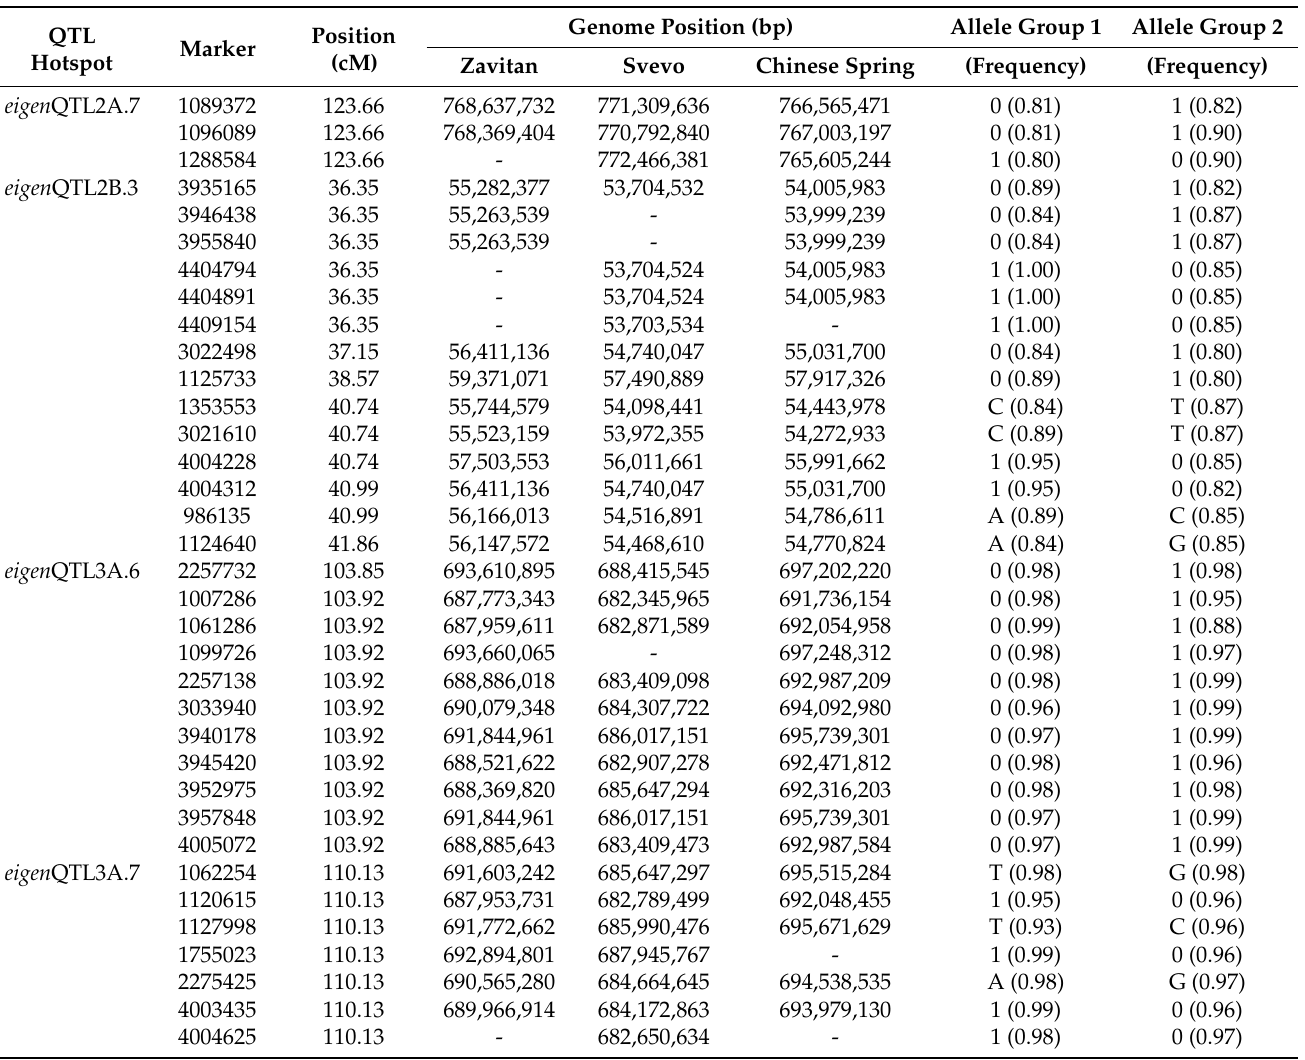
eigenQTL2B.3, eigenQTL3A.5, eigenQTL3A.6 and eigenQTL3A.7 (Table 3). However, rum wheat [23], and wild emmer [21], it was observed that markers corresponding to eigenQTL3A.5, eigenQTL3A.6, and eigenQTL3A.7 shared the same physical positions. Table 3. QTL hotspots involved in the selection showing allelic differences among the two PCoA